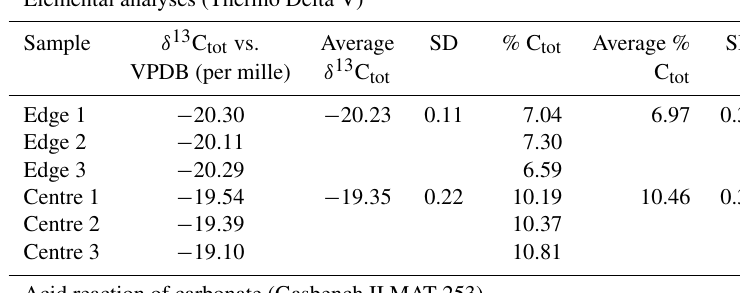
Table 1. Geochemical analyses of the concretion found in the glacial clay unit of core Asko2018HT-2GC. See Fig. 2a for core location and Fig. 7 for an image of the concretion. The upper section shows elemental analyses made using the Thermo Delta V mass spectrometer, and the lower analyses were made on phosphoric reactive carbon with a Gasbench II MAT 253 mass spectrometer (see “Material and methods” for further details).